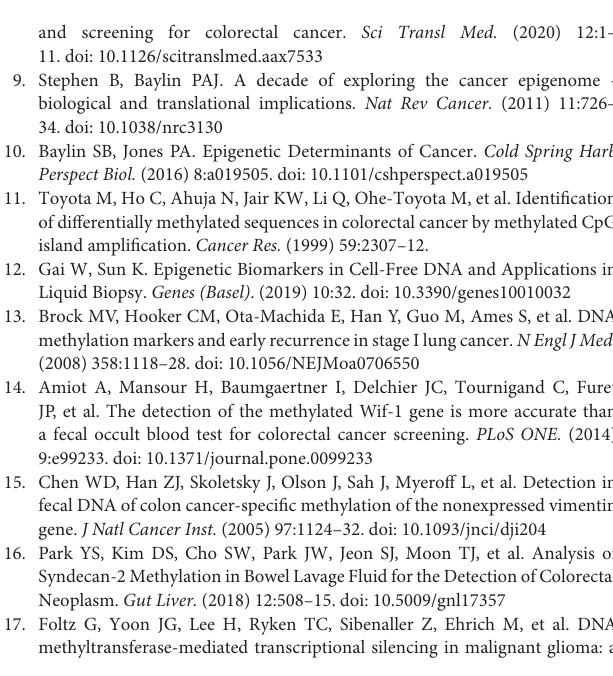
Supplementary Figure 3 | Forest plots for the SDC2 gene methylation tests on the detection of colorectal cancer (CRC). (A) Combined sensitivity and specificity forest plots. (B) Combined positive likelihood ratio and negative likelihood ratio forest plots. (C) Combined diagnostic ratio forest plots. Supplementary Figure 4 | Subgroup analysis of the detection of CRC by methylation of SDC2 gene from different sample sources, such as stool, serum, and plasma. (A–E) The pooled sensitivity, specificity, positive likelihood, and negative likelihood of SDC2 gene methylation from different sample sources, respectively. Supplementary Table 1 | The primer and probe sequences for assay. Supplementary Table 2 | ddPCR cycling